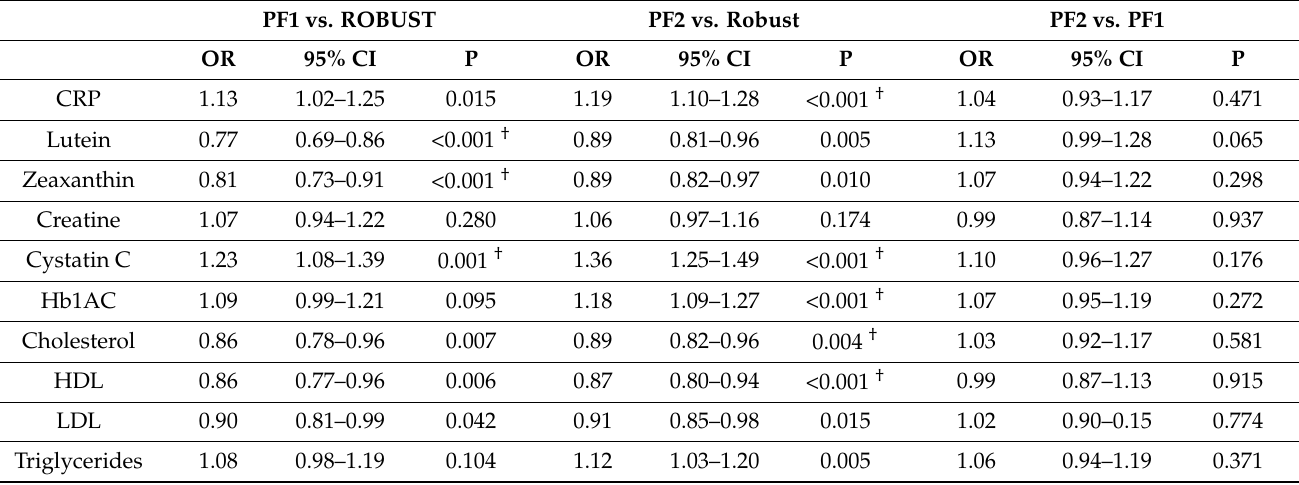
Table 3. Results of the binary logistic regression models adjusted for age, sex, and education. PF1 vs.